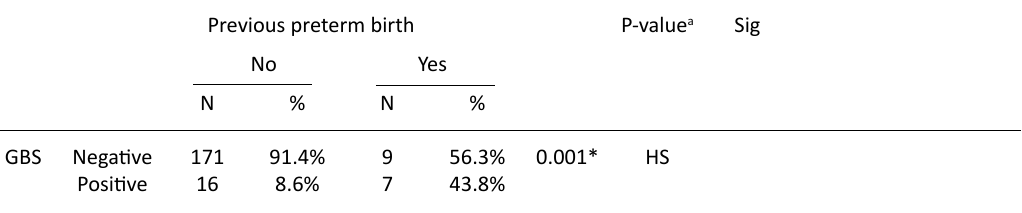
Table 4. Relationship between Previous preterm birth and GBS result among cases Previous preterm birth